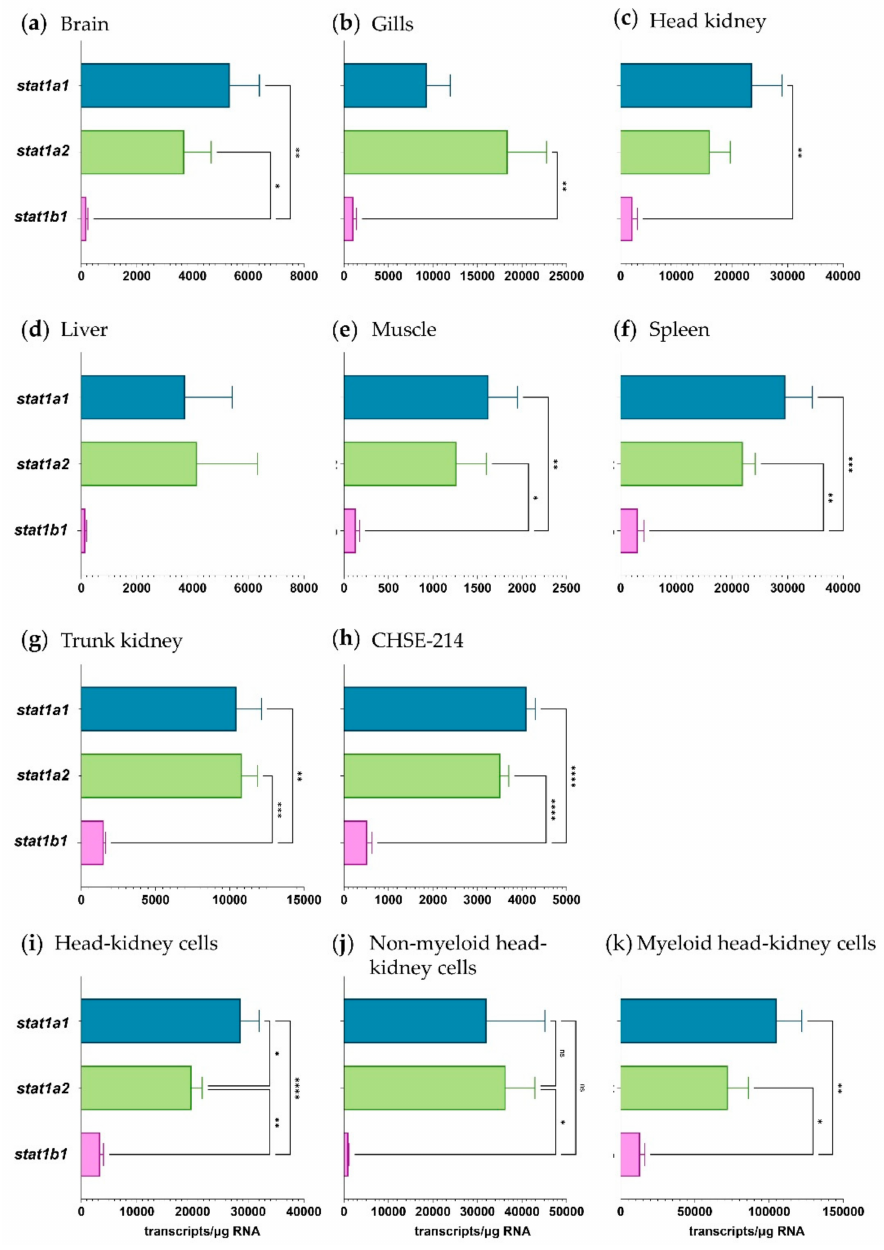
Figure 6. Expression profile of the stat genes in rainbow trout tissues and salmonid cells (as listed above the diagrams). Bars represent the averaged copy numbers ( n = 4) normalised against two reference genes; error bars represent the standard error of the mean. Asterisks represent significantly different transcript levels (*, p < 0.05; **, p < 0.01; ***, p < 0.001; ****, p <